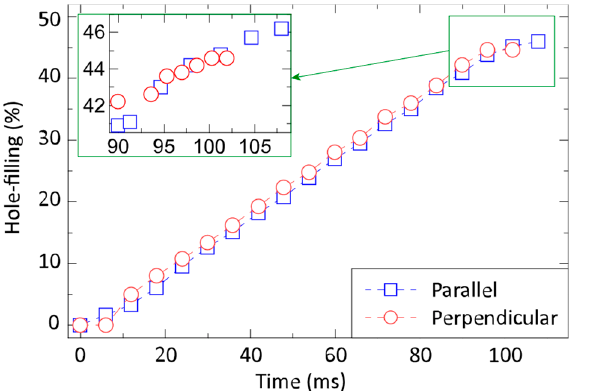
Figure 13. Comparing the hole-filling of rectangular-shaped holes (1 × 2 mm) oriented in parallel with or perpendicular to the travelling direction of the printing squeegee (printing speed was 120 mm/s).